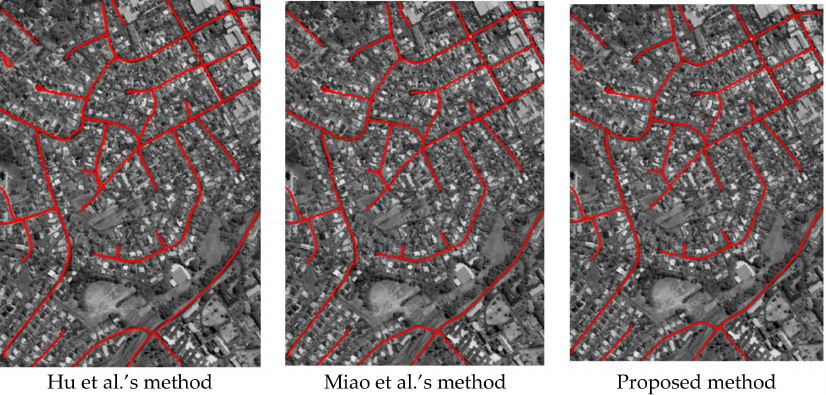
Figure 10. Comparison of the results provided by different road extraction methods for an IKONOS grayscale